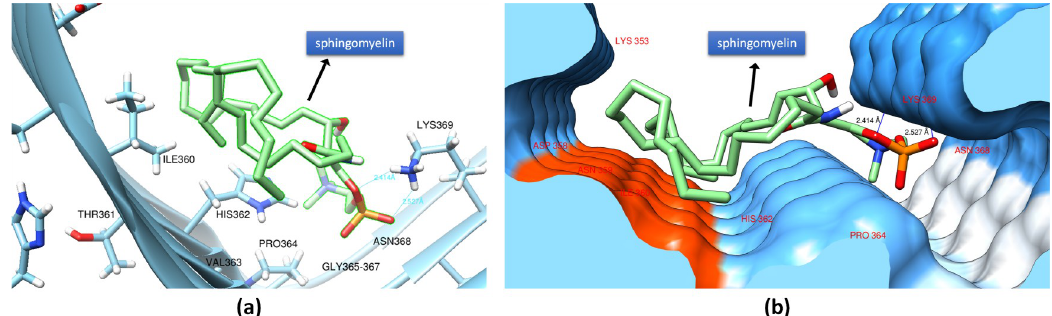
Fig 6. (a) The docking conformation of C18:1 Sphingomyelin on PHF-Tau showing the H-bond formation between C18:1 Sphingomyelin and the PHF-Tau backbone. (b) Hydrophobicity of the binding site (blue regions are hydrophilic and red orange regions are